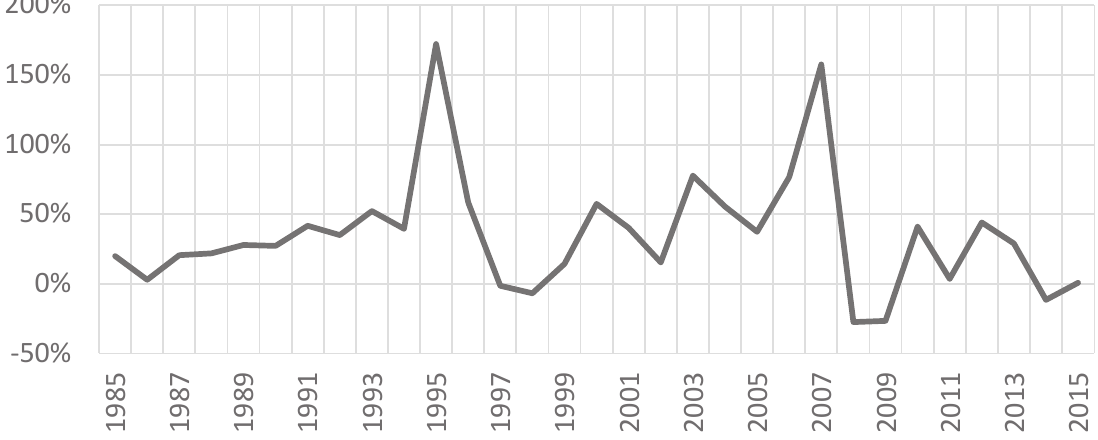
Figure 1. Trend of annual growth rate of NSE capitalization